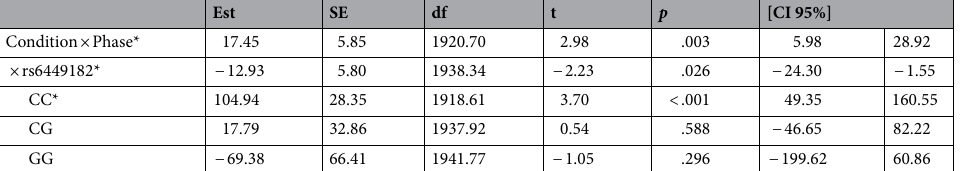
Table 3. GET effects on overall time spent within different expresser rs6449182 genotypes. * p < .05. The first row of condition × phase interaction shows the experimental effect; the second row shows how GET moderates the association between rs6449182 and time spent; the following three rows present the results of the simple effects of the condition × phase interaction within each expresser